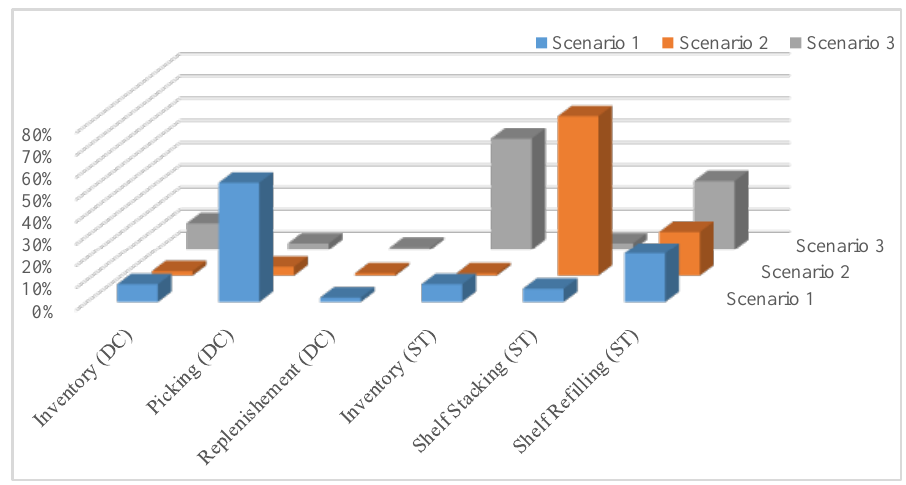
Figure 5. Impact of cost components on the total cost across the three